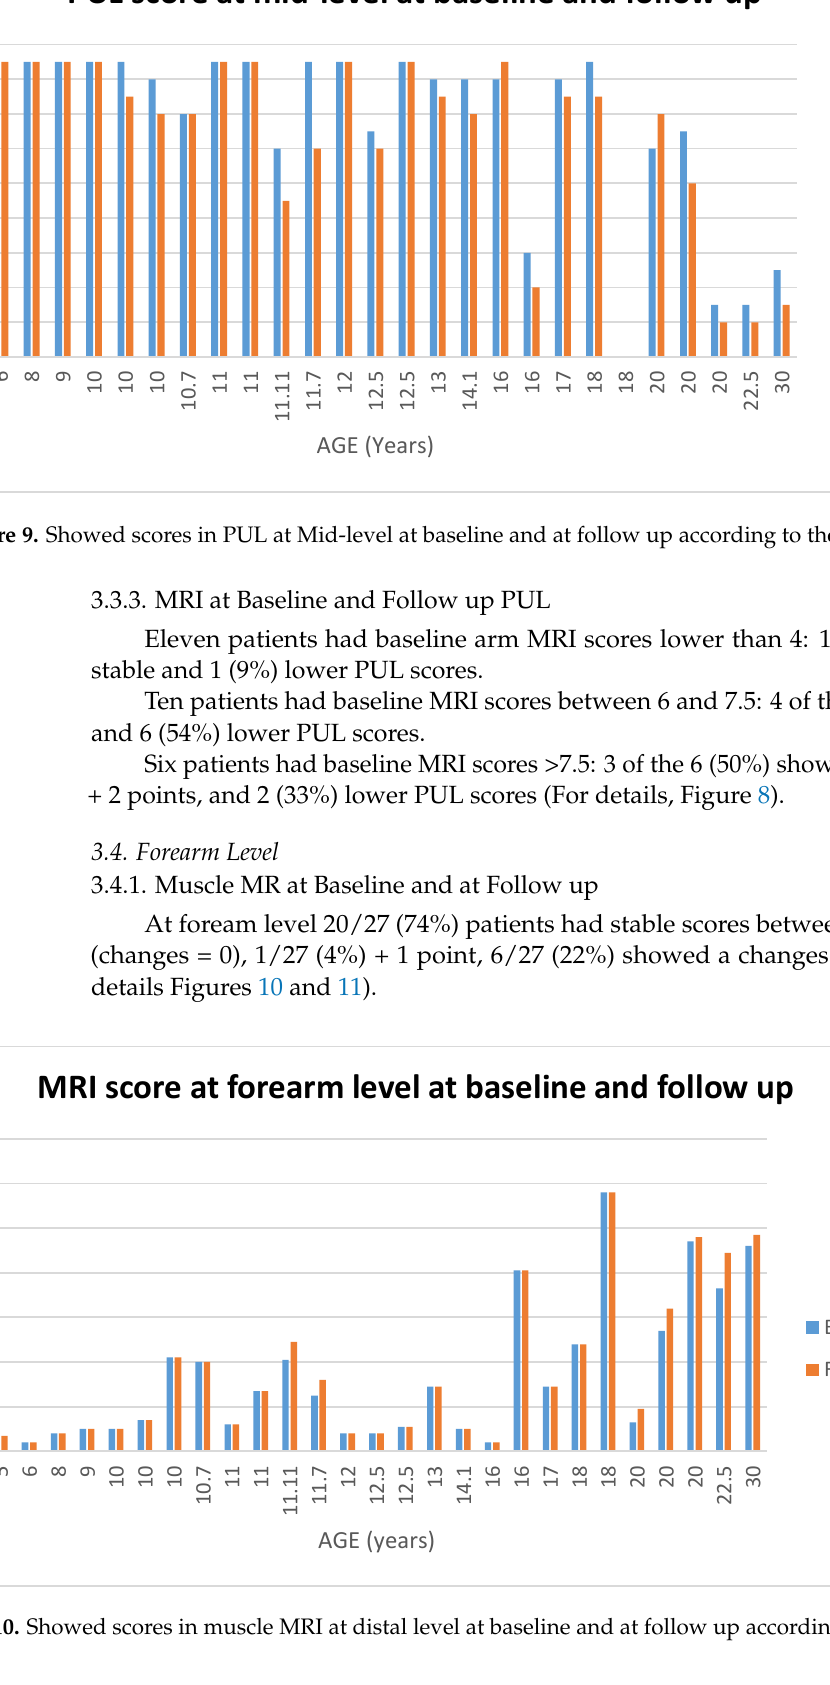
Figure 11. Detail of MRI and PUL at forearm level. Individual details of imaging and PUL findings at forearm level. The shading reflects the severity of involvement with the score of 0 shown as a white cell, score of 1 as pale green, score of 2 as yellow, score of 3 as orange and score of 4 as red. The grade 2.5 was used to identify patients with 2b involvement. Sup = supinator; pron = pronator teres; F cp = flexor carpi radialis; palm = palmar; F ds = flexor digitorum superficialis; F cu = flexor carpi ulnaris; Fdp = flexor digitorum profundus; Anc = anconeus; E cu = extensor carpi ulnaris; Edm = extensor digiti minimi; E d = extensor digitorum; E cr = extensor carpi radialis; Br R = brachioradialis; F pl = flexor pollicis longus; E pl = extensor pollicis longus. A= ambulant; EA = early ambulant; NA= non ambulant; ENA = early non ambulant; LNA: late non ambulant. ● Black circle means a higher Mercuri score respect to the baseline in the respective muscle. Blue line indicates changes in MRI scores.